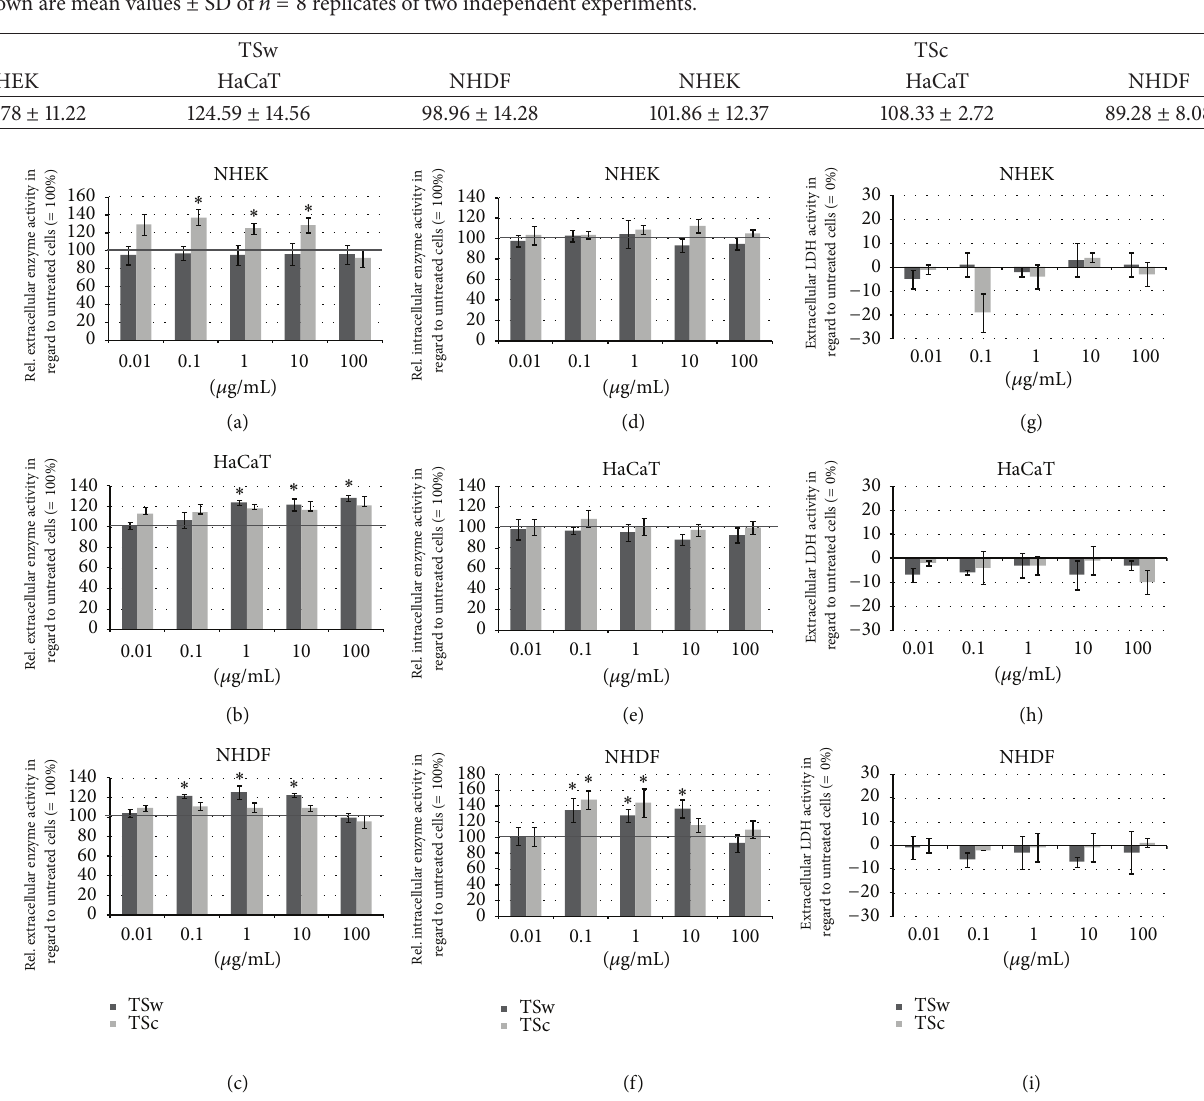
Figure 1: Cell viability of NHEK, HaCaT, and NHDF after incubation with 0.01–100 𝜇 g/mL TSw and TSc for 48h normalized to activity of untreated control cells (black line). Extracellular enzyme activity measured by WST-1 reduction is shown in (a) (NHEK), (b) (HaCaT), and (c) (NHDF). MTT reduction as indicator for intracellular enzyme activity is presented in (d) (NHEK), (e) (HaCaT), and (f) (NHDF). (g), (h), and (i) depict the extracellular LDH activity compared to extracellular LDH activity of untreated cells (=0%). Presented are the mean values ± SD of 𝑛 = 8 replicates of three independent experiments with ∗ 𝑃 < 0.05 compared to untreated